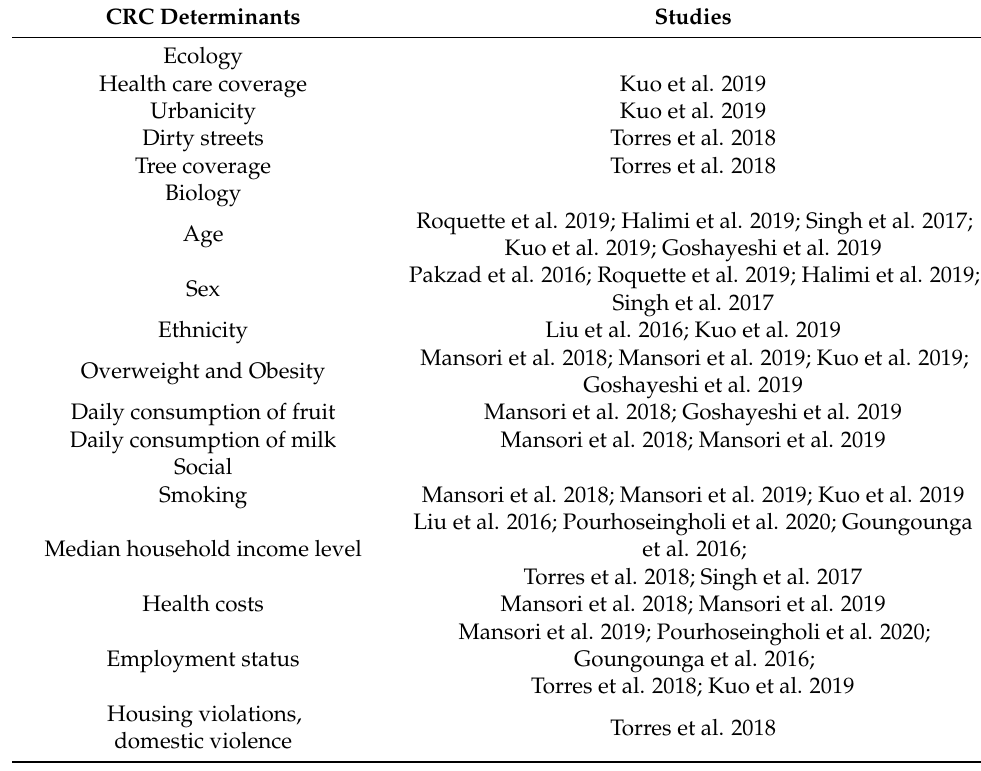
Table 4. Factors analyzed in each of the included